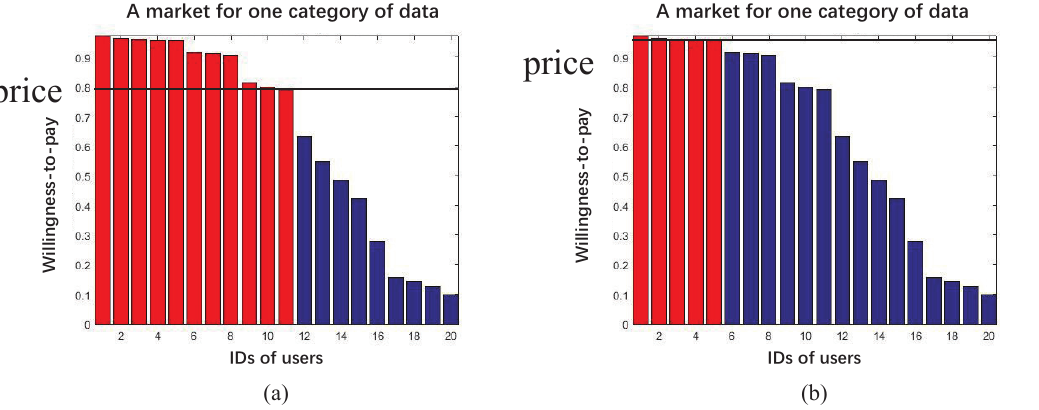
Figure 4. Demonstration of auction models. Prices are indicated by the horizontal dark lines. Those whose willingness-to-pay is above the price will stay (colored red), otherwise they will leave the market colored blue). Thus, when the price is higher, comparing the price in panel ( b ) to ( a ) , fewer people will remain in the